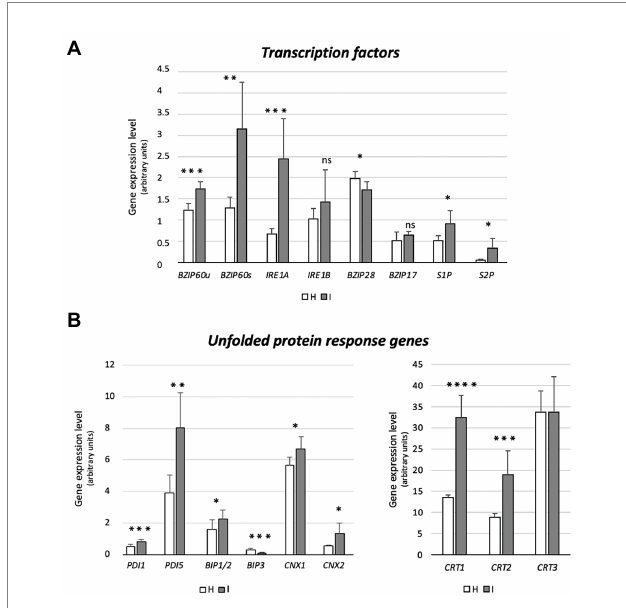
FIGURE 4 Expression of genes encoding UPR-promoting transcription factors ( bZIP60 , IRE1a , IRE1b , bZIP17 , bZIP28 , S1P , S2P ) (A) , and UPR proteins ( BiP1/2 , BIP3 , CNX1 , CNX2 , CRT1 , CRT2 , CRT3 ) (B) in healthy and infected midrib tissue. Expression values were normalized to the UBC9 transcript level, arbitrarily fixed at 100, then expressed as gene expression level (which corresponds to mean normalized expression, MNE) ± SD. At least five individuals (and tree technical repeats of PCR reaction) were used for MNE determination of each gene, in both healthy (H) and infected (I) plants. Statistical analyses were performed using an unpaired t-test. Family-wise significance and confidence level = 0.05 (* p < 0.05, ** p < 0.01, *** p < 0.001, **** p < 0.0001, ns: not